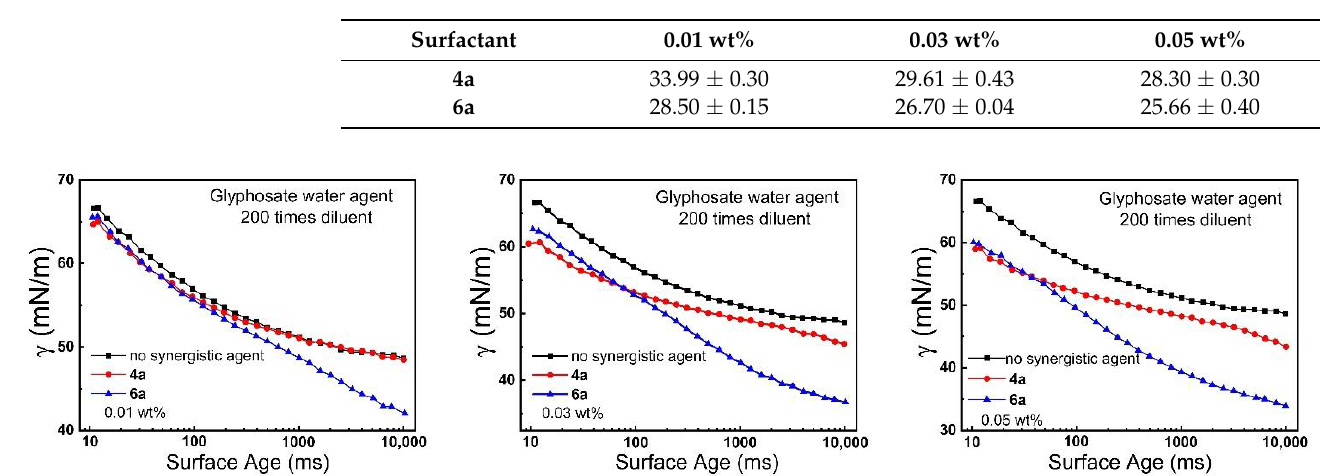
Table 5. Static surface tension data for aqueous solutions of glyphosate water agent containing surfactants 4a or 6a .